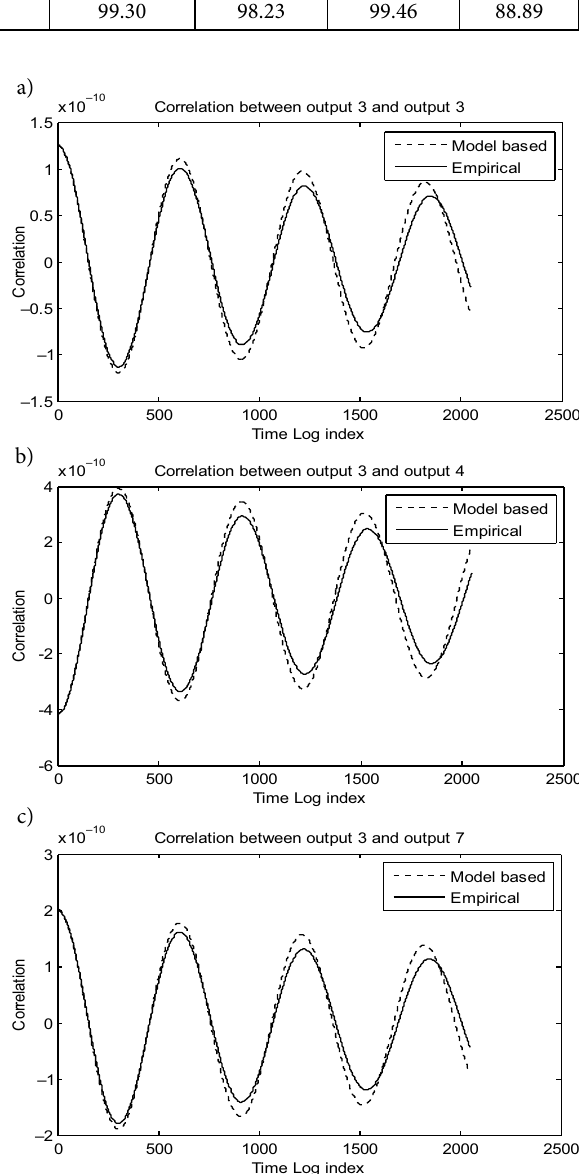
Fig. 4. Empirical correlations vs. model based ones of the Tripod simplex